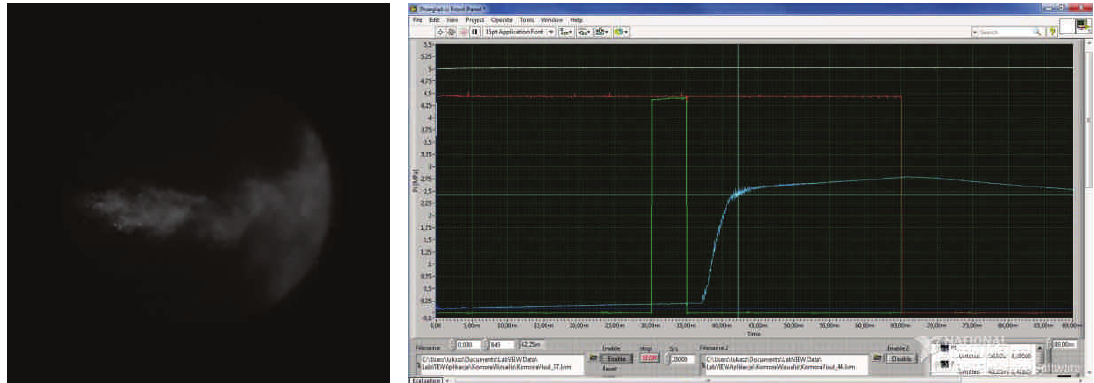
Fig. 4b. Photo of combustion advancement and pressure course with marked pressure value 7.25 ms after initiation of combustion. Combustion initiation – 35 ms after opening of injector